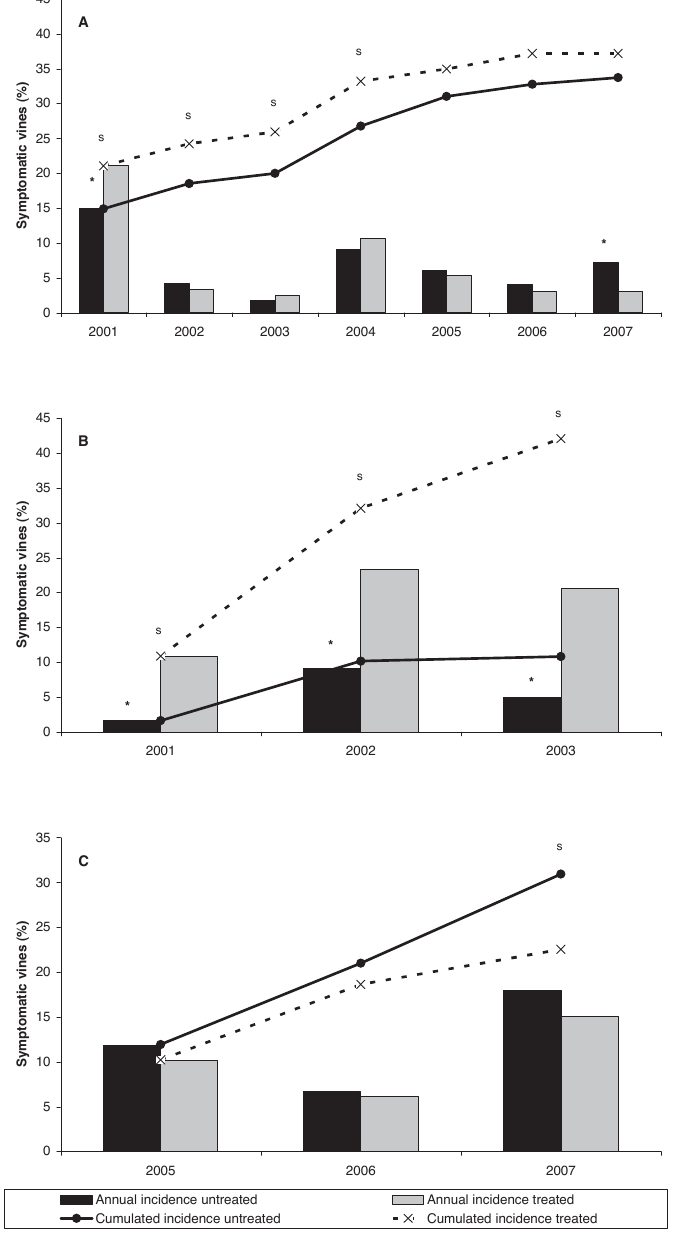
Fig. 2. Effects of applications of Brotomax (A), Fitostim (B) and Marvita (C) on annual incidence (bars) and cumulated incidence (lines) assessed in three different vineyards cv. Pignoletto. For each treatment and year of assessment, values of annual incidence or cumulated incidence marked with asterisk or “S” respectively, differ signi fi cantly according to Chi–Square test ( P